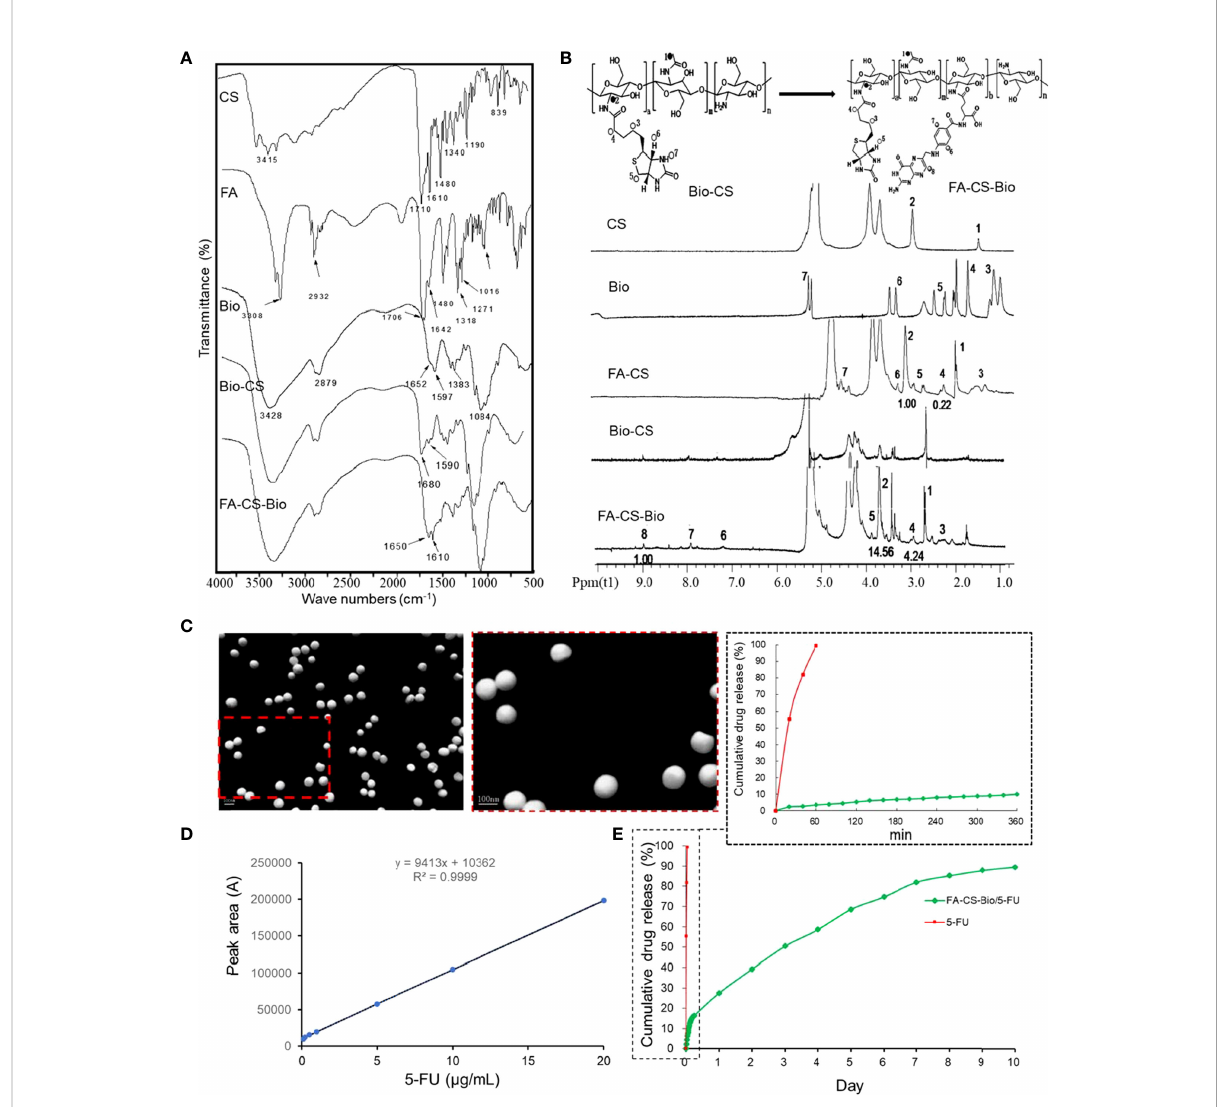
FIGURE 1 Synthesis and sustained release of FA-CS-Bio nanomaterials (A) Fourier transform infrared spectra of different nanomaterials; (B) 1 H NMR of different nanomaterials; (C) Transmission electron microscope image of FA-CS-Bio/5-FU nanoparticles; (D) Preparation of 5-FU standard curve; (E) In vitro release of FA-CS-Bio/5-FU